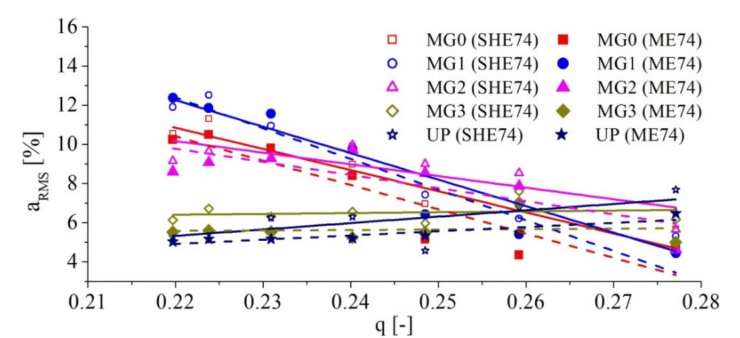
Figure 9. The dimensionless equivalent amplitude of the power spectra induced by the self-induced flow instabilities on the test section wall for two draft tube configurations (SHE74—solid line and ME74—dashed line) versus the discharge coefficient. Linear fits of the experimental data given by solid and dashed lines highlight the trends.